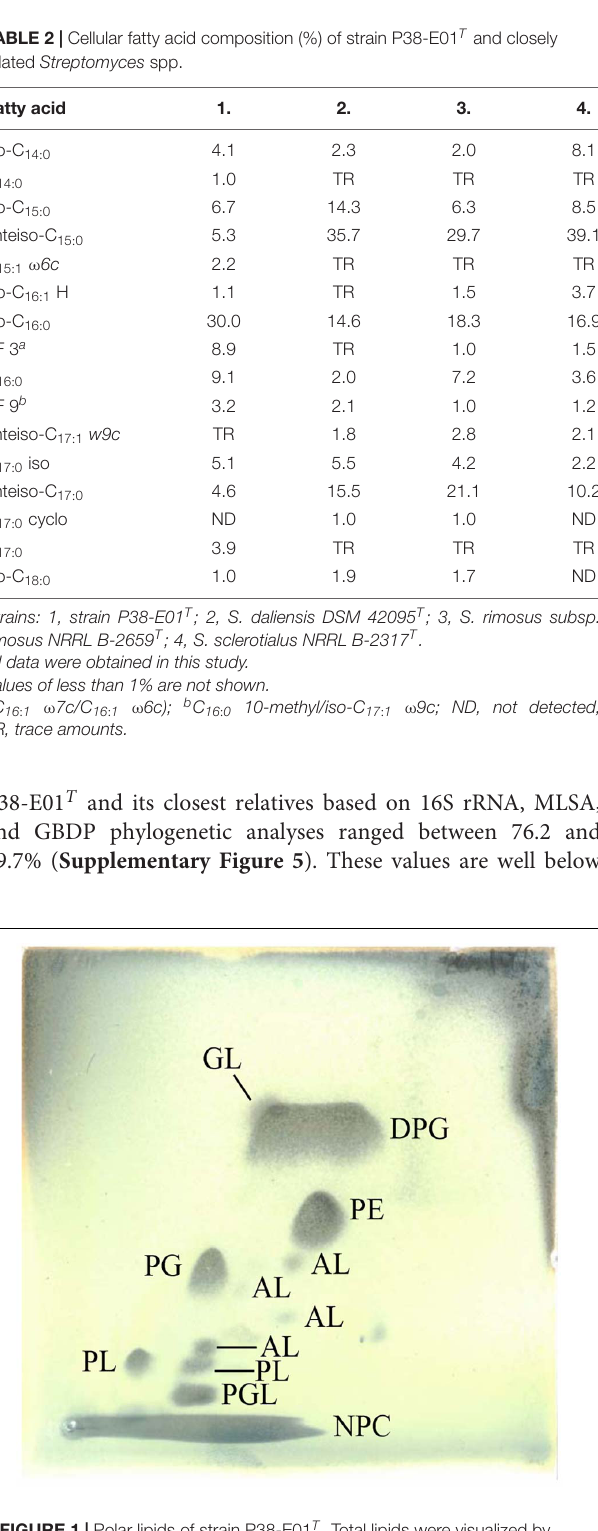
FIGURE 1 | Polar lipids of strain P38-E01 T . Total lipids were visualized by two-dimensional TLC applying 5% molybdatophosphoric acid. Abbreviations: AL, aminolipid; DPG, diphosphatidylglycerol; GL, glycolipid; NPC, non-polar compound (co-extracted with polar lipids); PE, phosphatidylethanolamine; PG, phosphatidylglycerol; PGL, phosphoglycolipid; PL,